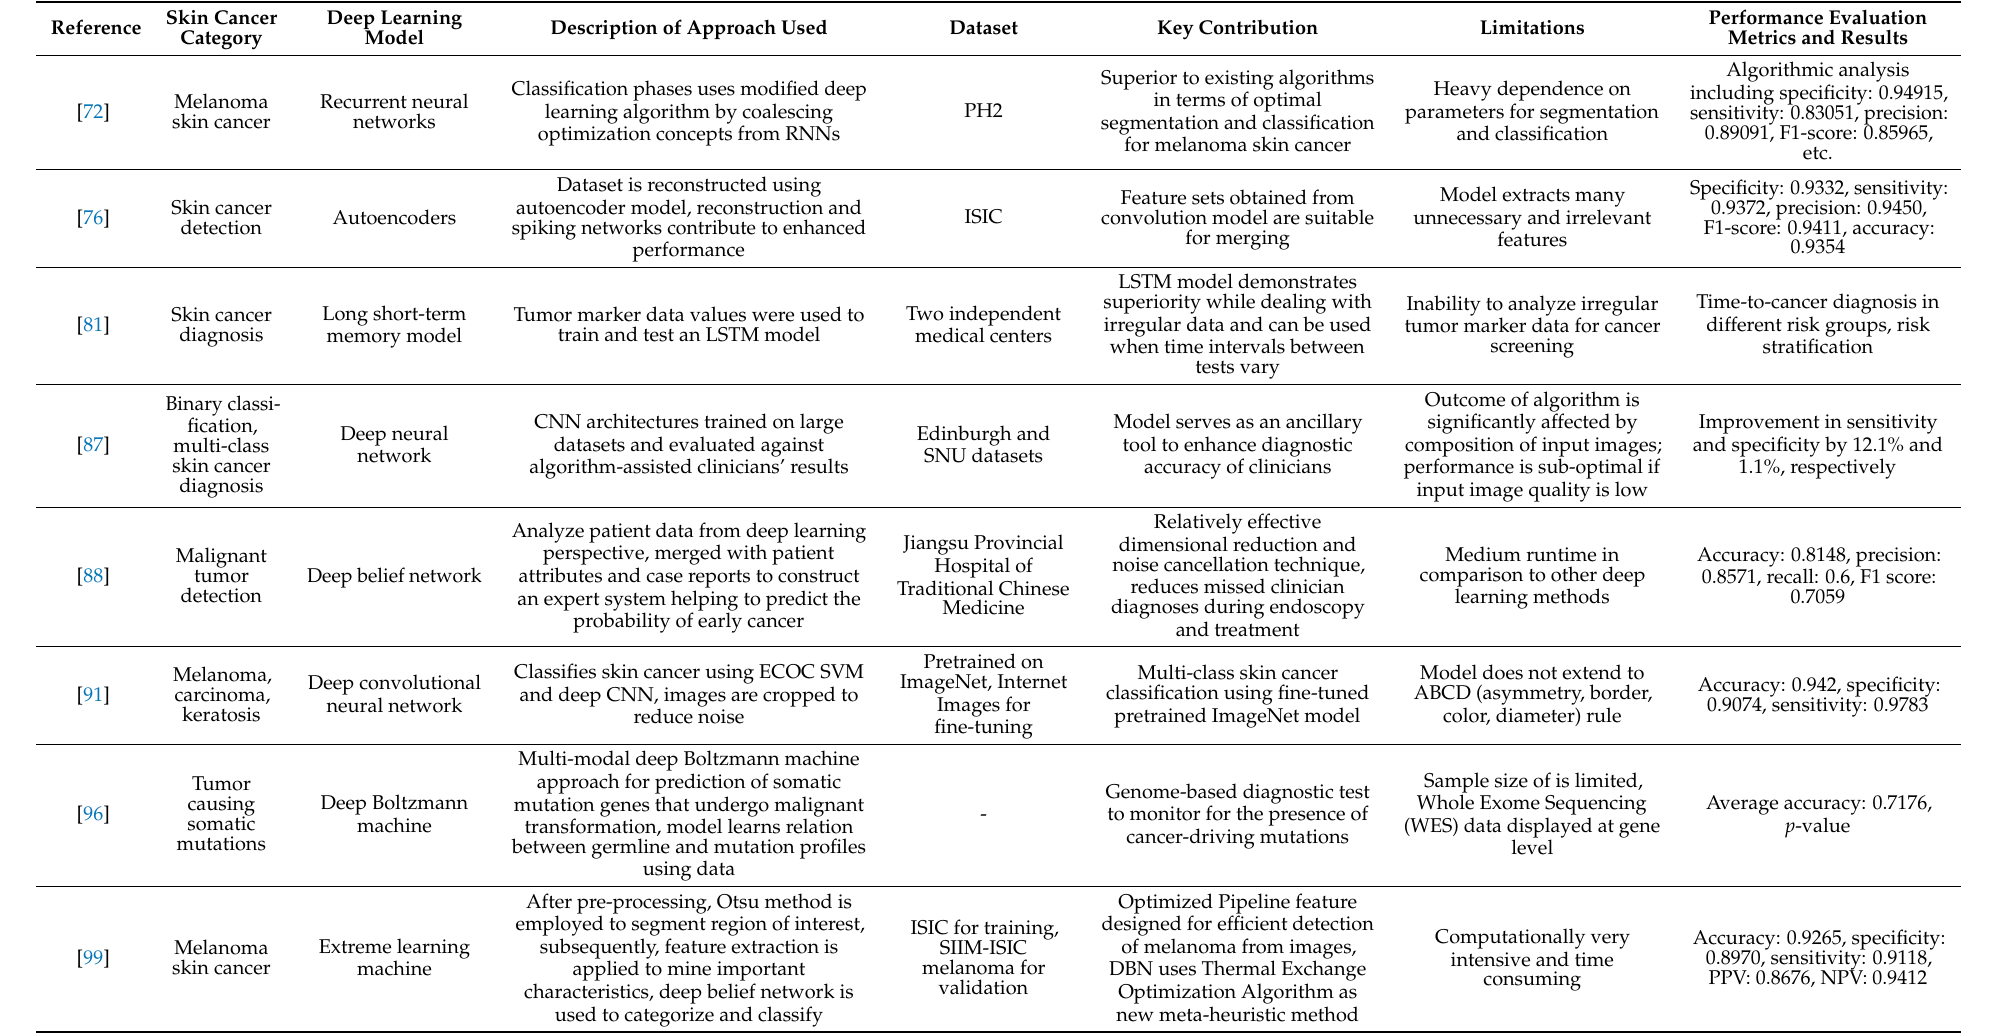
Table 5. Summary of works on deep learning models in skin cancer